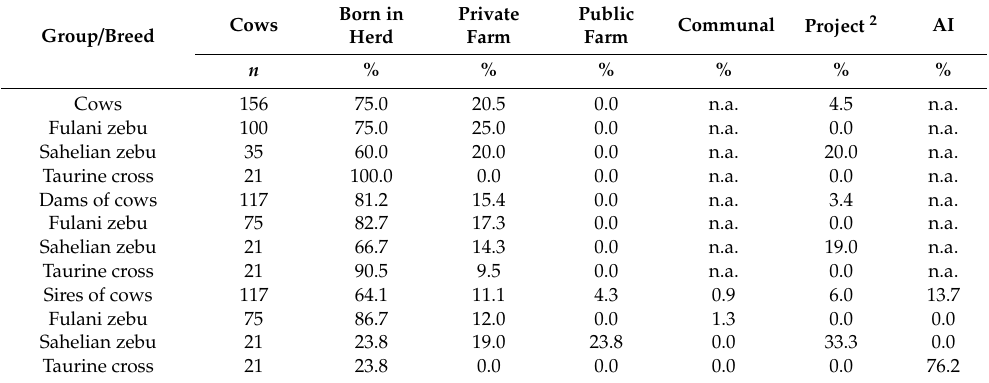
Table 3. Source of cows 1 and cows’ sires and dams owned by cattle breeders in Ouagadougou ( n = 49). Born in Private Cows Group / Breed Herd